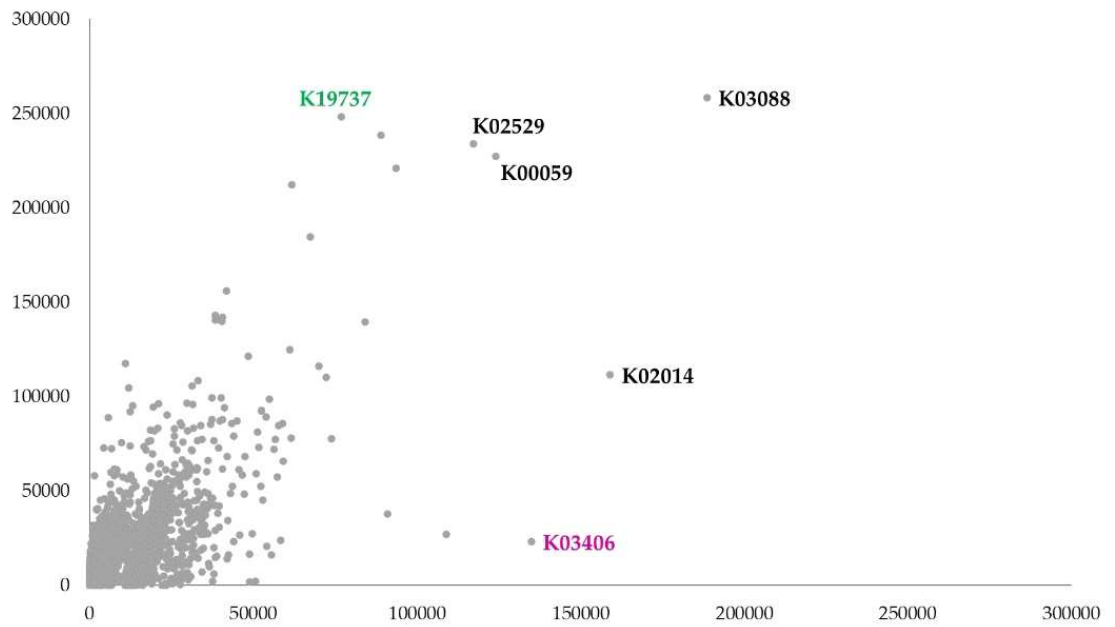
Figure 4. Correlation plot on enzymes predicted by PICRUSt 2 software [37] (nodule y axis and rhizosphere x axis). In Figure 4, the EC codes refer to the enzyme commission numbers of the KEGG database. Only ECs with relative counts higher than 100,000 were labeled in black. The green label highlights the EC with higher counts in nodule sample while the magenta one shows the EC with higher counts in the rhizosphere. Correlation coefficient: 0.84.